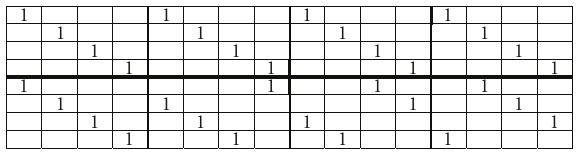
The algorithm constructs a distance graph code rows in step 3 of algorithm. Row r x , which is at a distance of at least g from r i , is searched sequentially or randomly in RGP t (2). A sequential search traverses a row group in ascending or de- scending order. If r x is found, the rest of the rows are con- nected relative to r i and r x if the girth condition is not vio- lated. Figure 2 shows row connections for a (16, 2, 4) LDPC code with girth eight constructed using the proposed algo- rithm. There are two groups of size 4. The first group and row 1 are always chosen as the reference group and row, respec- tively. A sequential search is used in group 2. The first group has rows 1 to 4 and the second group has rows 5 to 8. Since there are only two groups (group 1 and 2), the groups pair- ings are [1 2], [1 2], [1 2], [1 2] with each group appearing four times (desired row-weight). In the first connection row 5 is found to satisfy the distance of four (desired girth) from row 1. The rest of group 1, rows 2 to 4, are then connected to rows 6 to 8. In the second connection, row 6 is the first to satisfy the distance. It is connected to row 1 with the rest of group 1 connected to the rest of group 2. The process is re- peated in connections three and four as shown in the figure. The row connections form a distance graph with the num- ber of vertices equal to eight, a vertex degree equal to four and a girth of four. Figure 3 shows a matrix representation of the obtained code. Each set of connections forms a column group with each row group as a 4 × 4 submatrix. Since the first group is not searched or shifted, rows in this group are connected in their natural order in each submatrix. The top four rows contain four unshifted identity submatrices corre- sponding to four connections for group 1 rows. Group 2 rows are connected in their natural order only in the first connec- tion. The bottom 4 × 4 submatrices represent group 2 con-